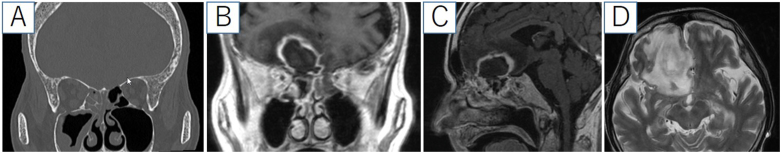
Preoperative CT and contrast-enhanced MRI: (A) CT showing acute rhinosinusitis without bone erosion; (B, C) gadolinium-contrasted T1-weighted image showing a brain abscess with a rim of peripheral enhancement localized in the frontal sinus adjoined the skull base at the posterior ethmoid sinus; (D) T2-weighted image showing brain edema in the frontal lobe around the brain abscess.